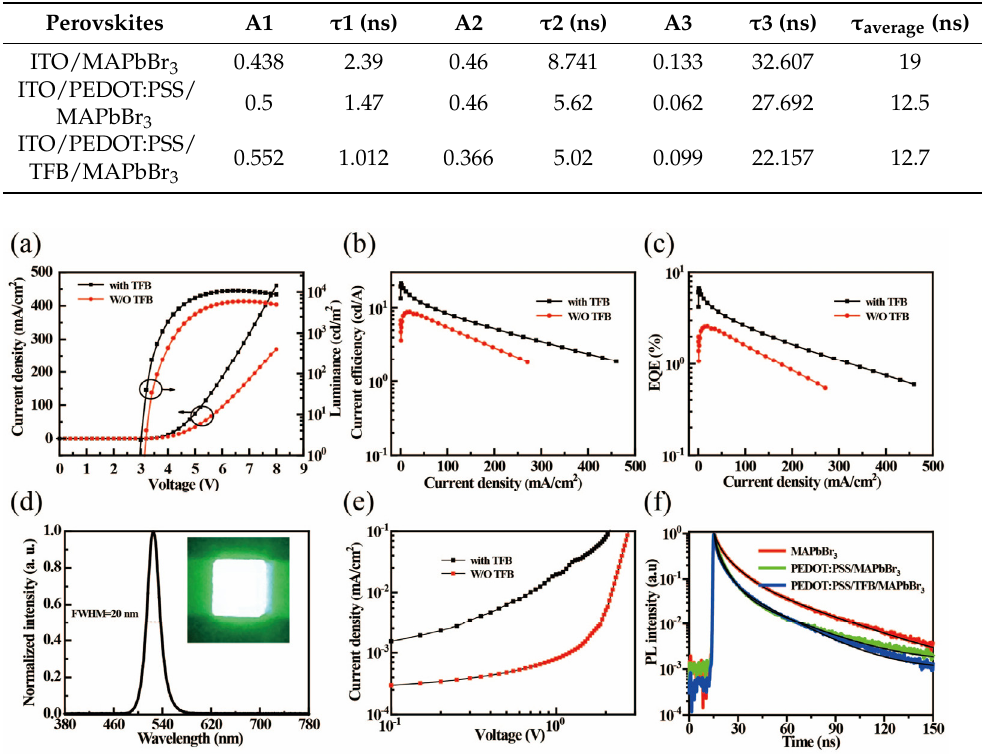
Figure 4. ( a ) J − V − L, ( b ) CE − J, ( c ) EQ − J characteristics of the PeLEDs with and without TFB HTLs. ( d ) Normalized EL spectra of the devices (Inset: The emission image of the optimal device driven at